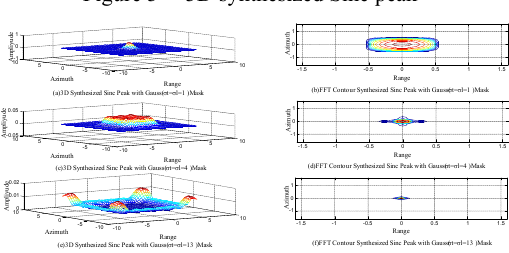
Figure 3 3D synthesized Sinc peak